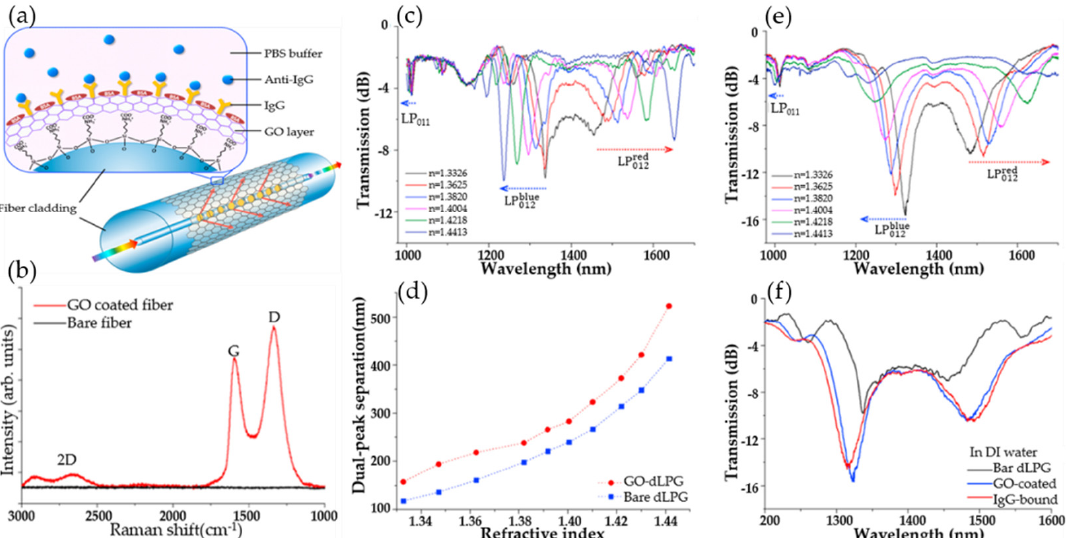
Figure 5. ( a ) Schematic diagram of optical fiber biosensor comprising the dLPG coated with the graphene oxide-linking layer. ( b ) The Raman spectrum of GO-coated fiber compared with bare fiber. ( c ) Transmission spectra of bare dLPG measured in different sucrose concentrations. ( d ) Dual-peak wavelength separation against SRI. ( e ) Transmission spectra of bare dLPG measured in different sucrose concentrations. ( f ) Spectra evolution of non-coated, GO-coated, and IgG-immobilized dLPG. Reproduced from [93] with permission of Elsevier.